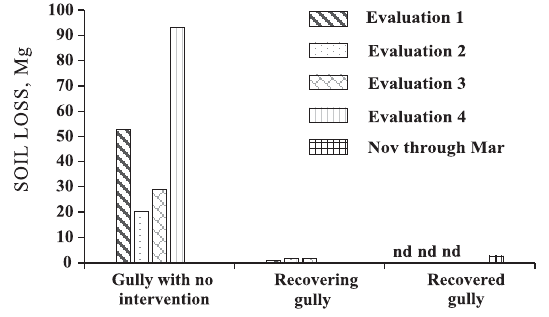
Figure 1. Soil loss at gullies at different stages of recovery from different